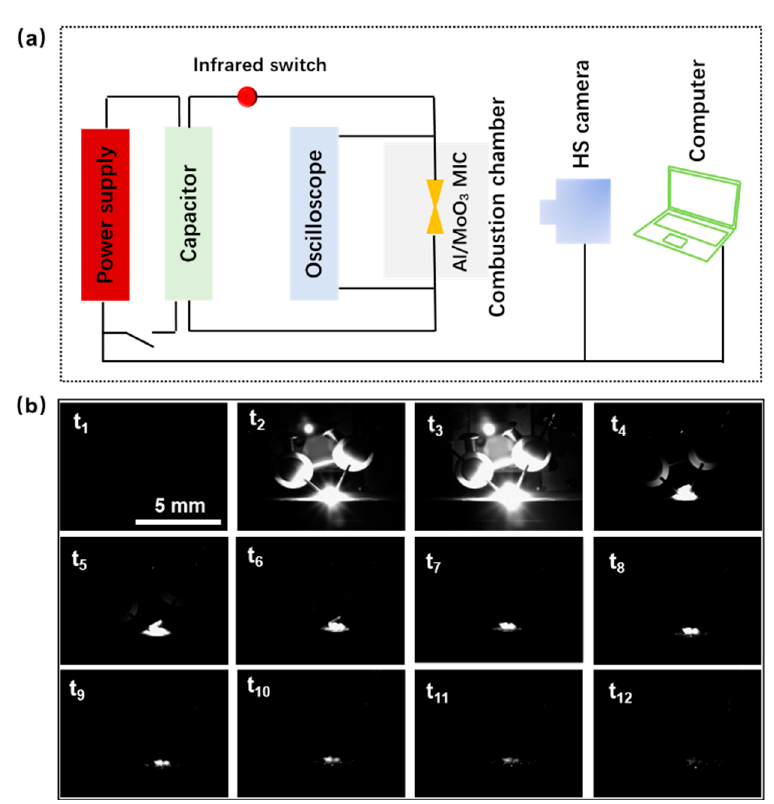
Figure 6. ( a ) Schematic of the ignition system for the micro nano-Al/MoO 3 MIC chip initiator, and ignition process recorded by a high-speed camera; ( b ) series of still images taken from a typical ignition deflagration study of the nano-Al/MoO 3 MIC fabricated by EPD process with Φ d = 1.0; the time interval between images is 0.1 ms ( t n − t n − 1 = 0.1 ms, n ≥ 2 ).